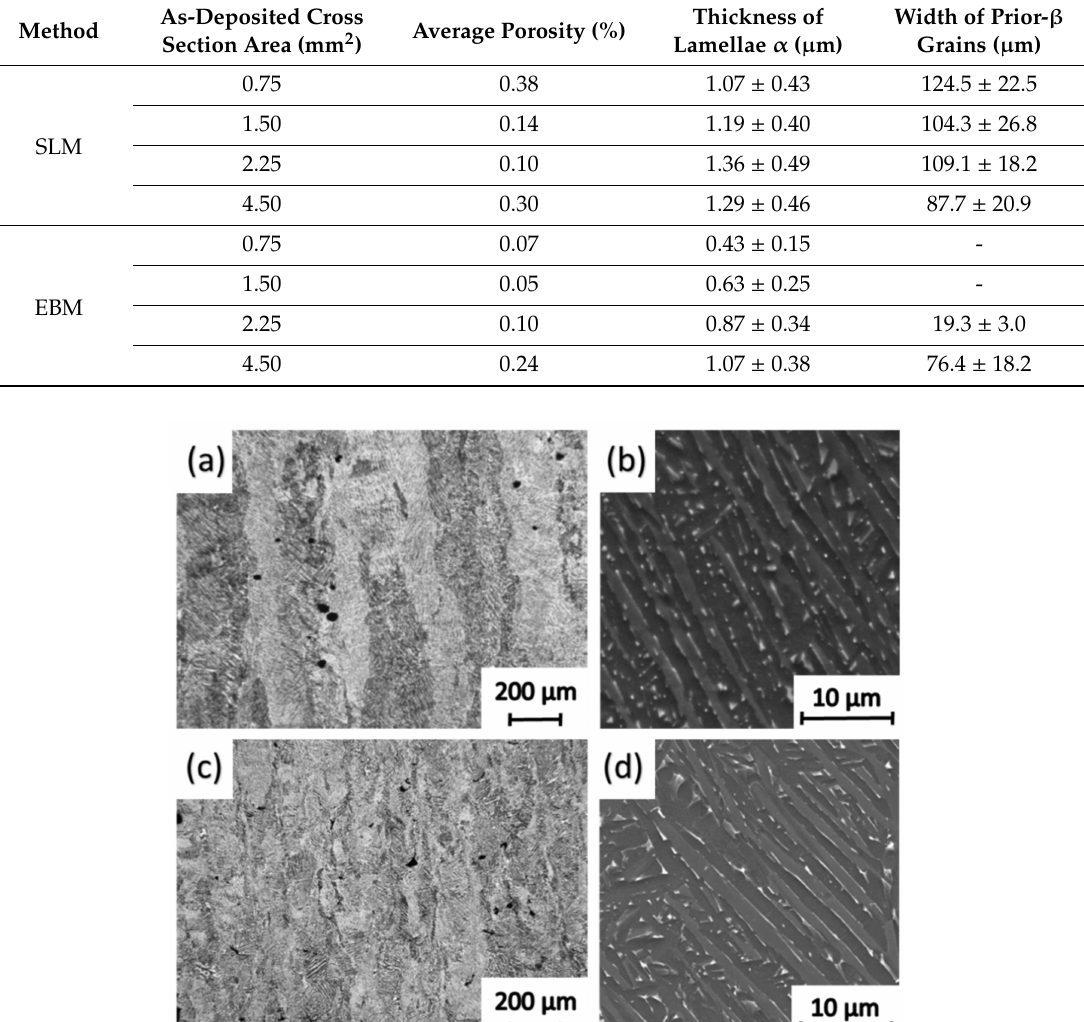
Table 5. Image analysis results—porosity, thickness of α lamellae, and width of prior- β grains. Data for SLM-processed material included from previous work.